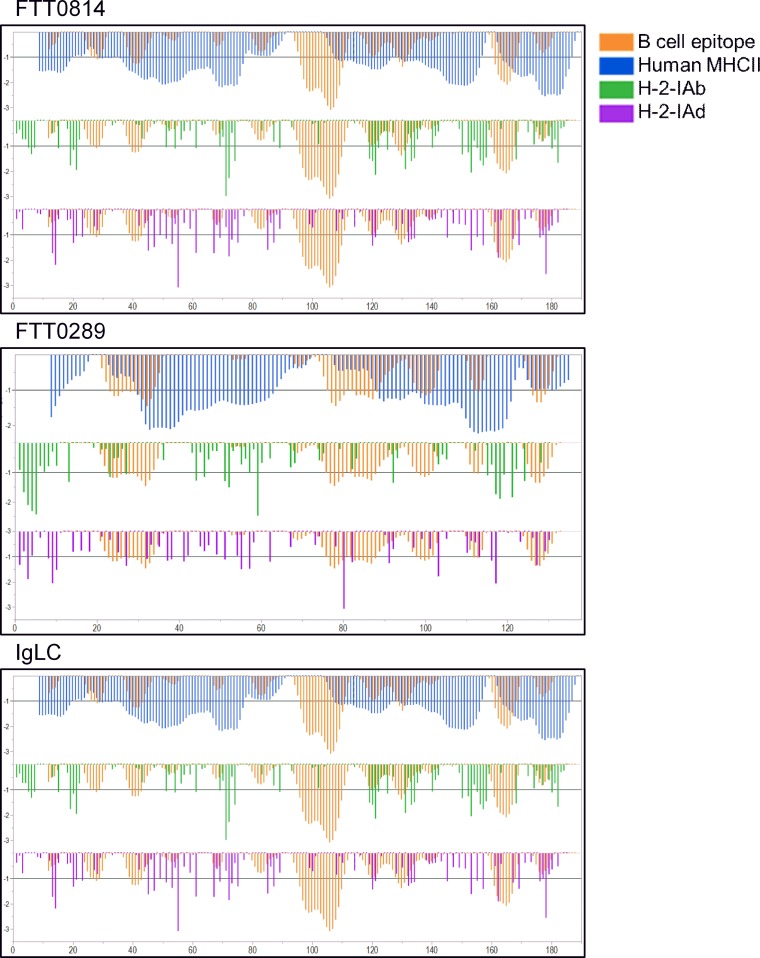
Comparison of human and murine MHC II binding patterns and B cell linear epitopes.For each of the three proteins FTT0814, FTT0289 and IglC, the predicted MHCII binding affinity of sequential 15-mer peptides is shown on the X axis, positioned by index amino acid position of each 15-mer. Within each panel, the top tier shows the average predicted binding to human MHC II, averaged for DRB alleles (blue). The middle tier shows the predicted binding to H-2-IAb for C57Bl/6 mice (green). The bottom tier shows predicted binding to H-2-IAd for Balb/C mice (purple). Overlayed onto each of the human MHCII, H-2-IAb and H-2-IAd binding predictions are the probable B cell linear epitopes (orange). Y axis units for MHC binding are standard deviation units below the mean of the natural log binding affinity (lnIC50) for that protein; and inverted standard deviation of linear B cell epitope probability (inverted).